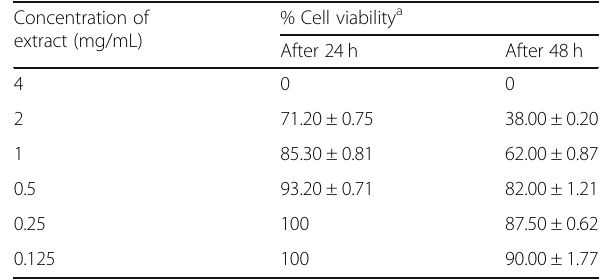
Table 3 Cell viability of BHK-21 cells treated with direct aqueous extract (reflux) of Terminalia bellirica